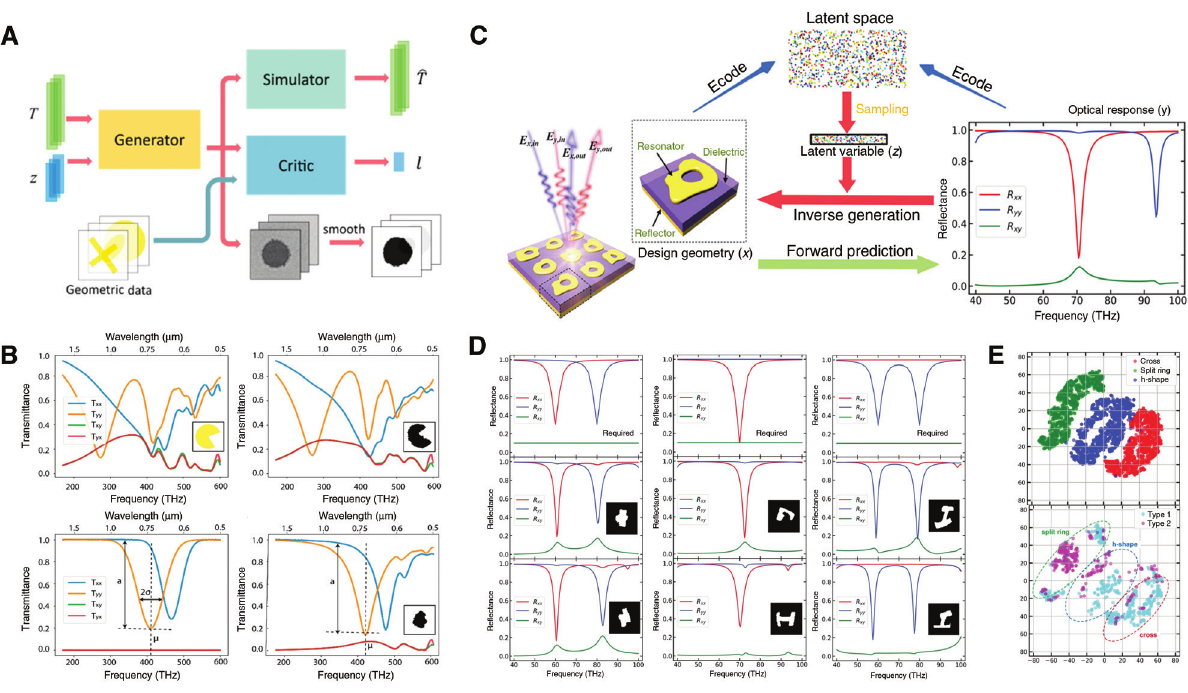
Figure 5: Inverse design using unsupervised learning methods. (A) A GAN model to inverse design structural images. (B) Examples of the results of the inverse design. Full sets of transmission spectra (left) of the inputs (right) obtained from the designed structures. Insets are the associated structural images. (C) A schematic of inverse design using VAE. (D) Examples of the results. The top spectra are target spectra, and the middles and bottoms are two examples of the retrieved structural designs (insets) and their associated reflection spectra. (E) Visualization of the latent space. (A) and (B) are reprinted with permission from Ref. [60], Copyright 2018 American Chemical Society. (C–E) are adapted with permission from Ref. [72], Copyright 2019 WILEY-VCH Verlag GmbH & Co. KGaA,